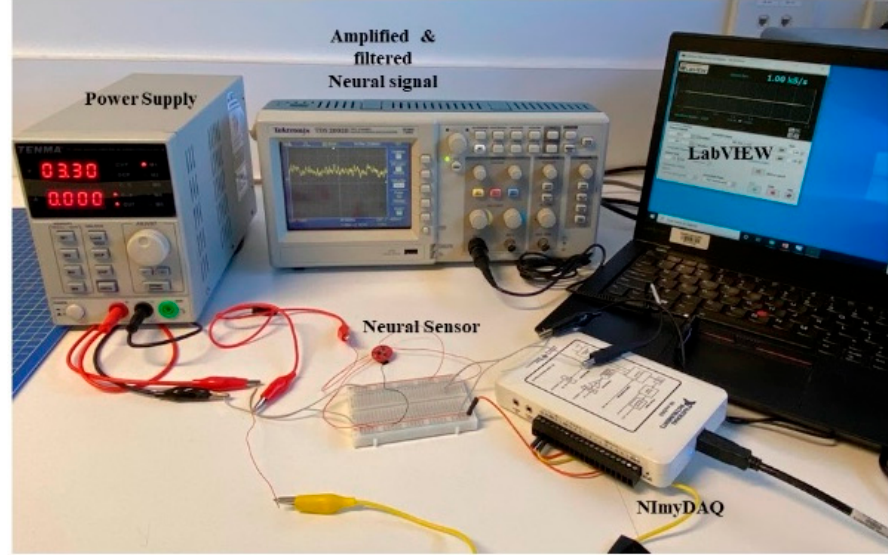
Figure 10. Experimental design for the neural sensor with pre-recorded neural signals.